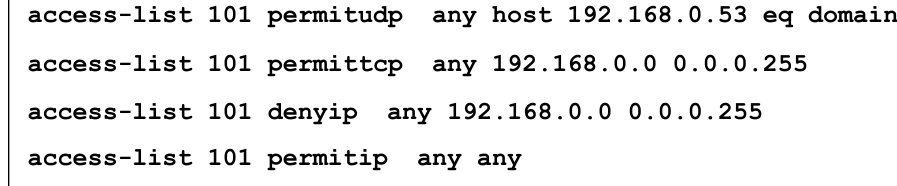
Figure 6. ACL configuration on the IoT-subnet interface of the home